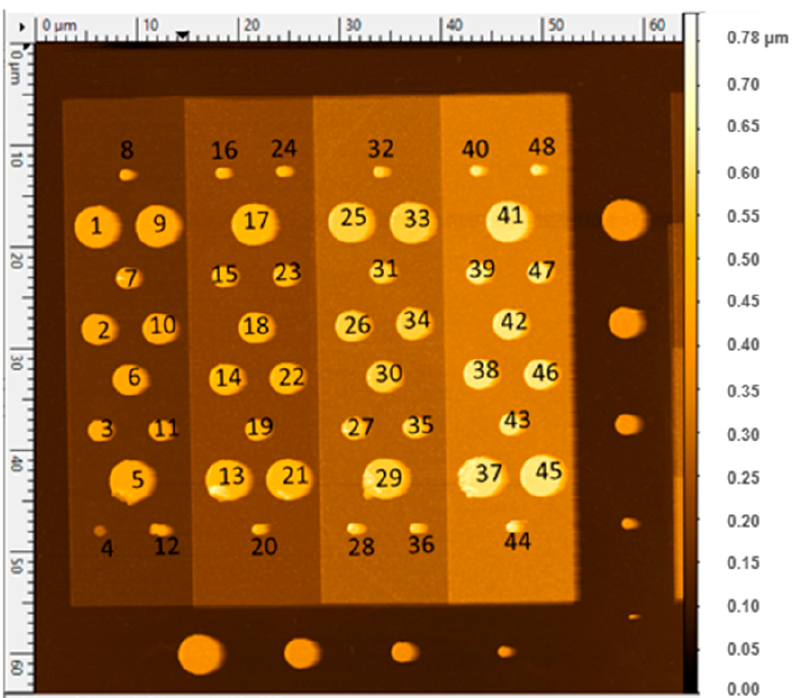
Figure 1. Atomic force microscope (AFM) image of a pattern from A61 sample composed of micro- capacitors labelled 01 to 48 and two sets of Schottky diodes on two sides. This figure has been produced using Gwyddion open source software